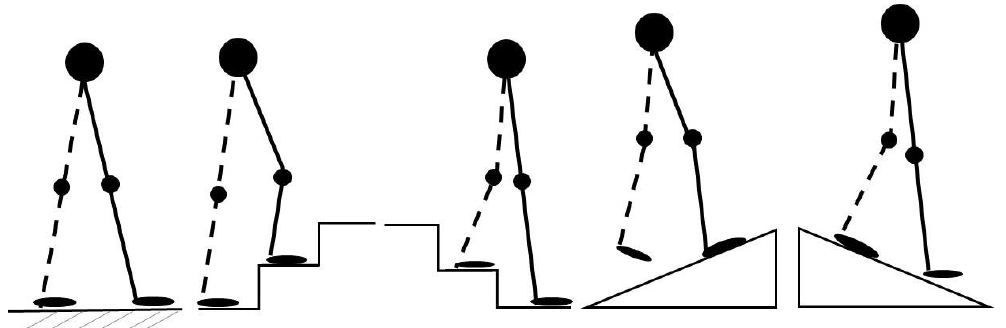
Figure 4. Five classic